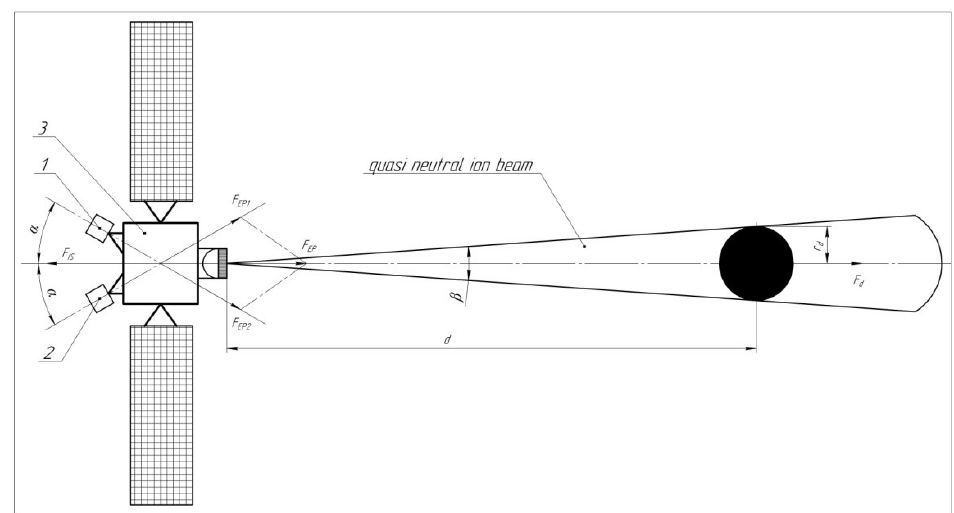
Figure 1. Forces arising in the “SSC-SD” virtual assembly ( F IS is the force acting on the SSC (3) from the IS; F EP is the force acting on the SSC from the compensating propulsion system (1,2); F d is the force acting on space debris).